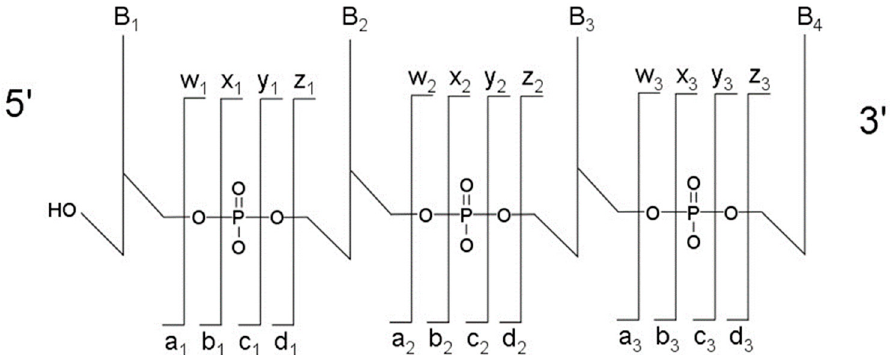
Figure 3. Sequence ladder of possible fragmentation sites for an RNA oligonucleotide by collision-induced dissociation fragmentation. B 1 , B 2 , etc. represent the nucleobase of the RNA, while a 1 , w 1 , etc. are the accepted nomenclature to denote the bond that is cleaved. Adapted from [41].